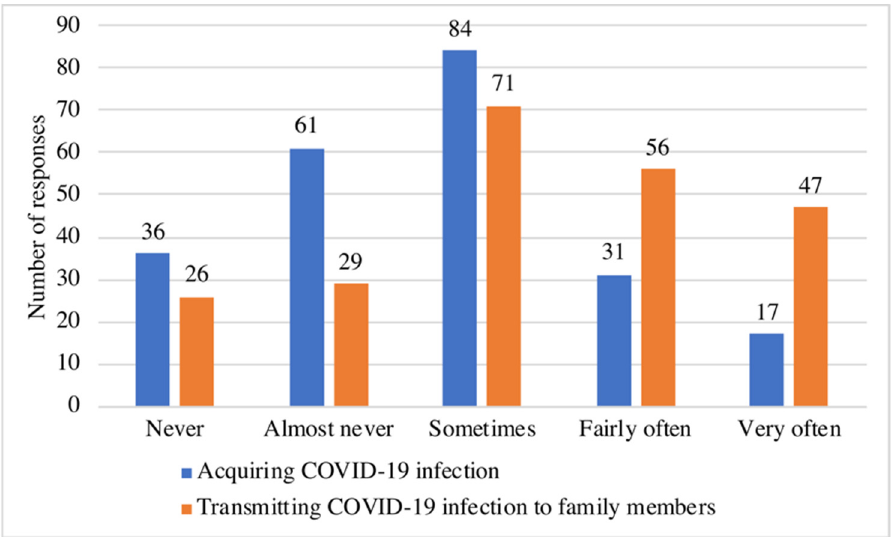
Figure 1. Frequency of sources of stress reported by the residents ( n = 200).